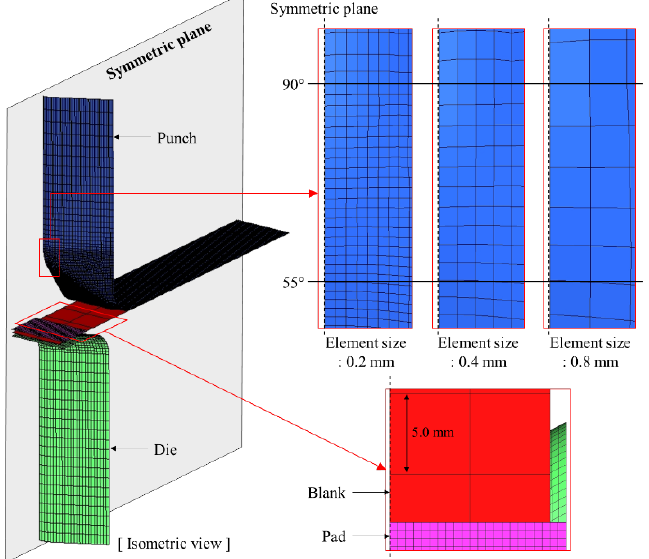
Figure 5. FE modeling to evaluate mesh size sensitivity at the stamping process contact interface. Table 5. FE model details and computational time for each element size case.